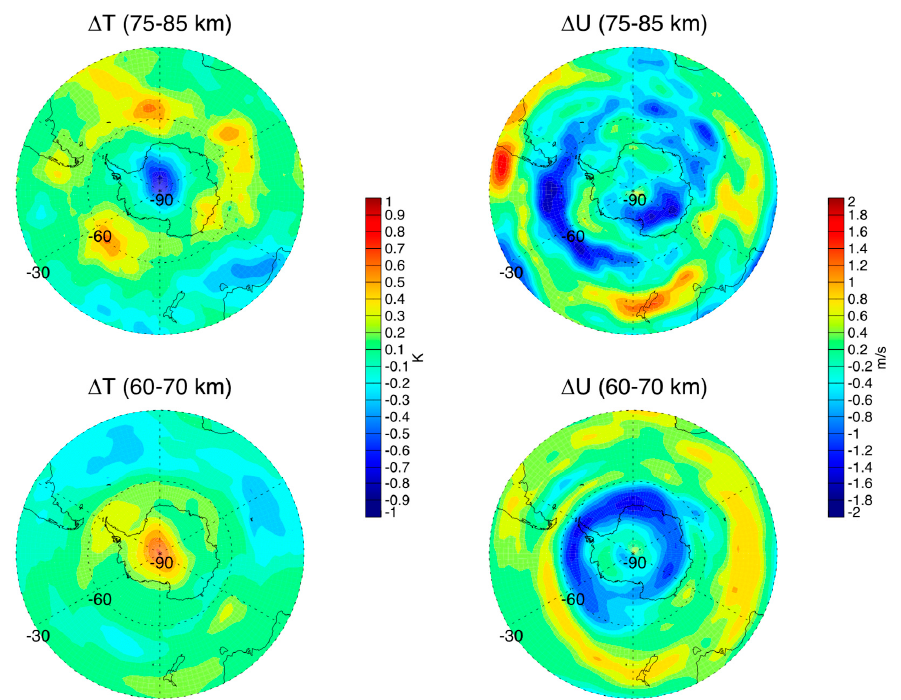
Figure 9. The differences (MEE-Control) of the temperature and zonal wind are presented in the altitude range of 75–85 km (top) and 60–70 km (bottom) during southern winter (JJA) from 2005 to 2013.